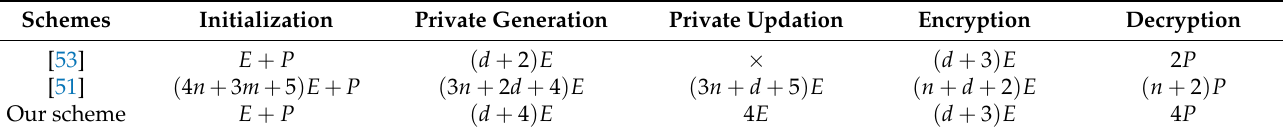
Table 5. Comparisons of the calculation efficiency of our scheme and the schemes of